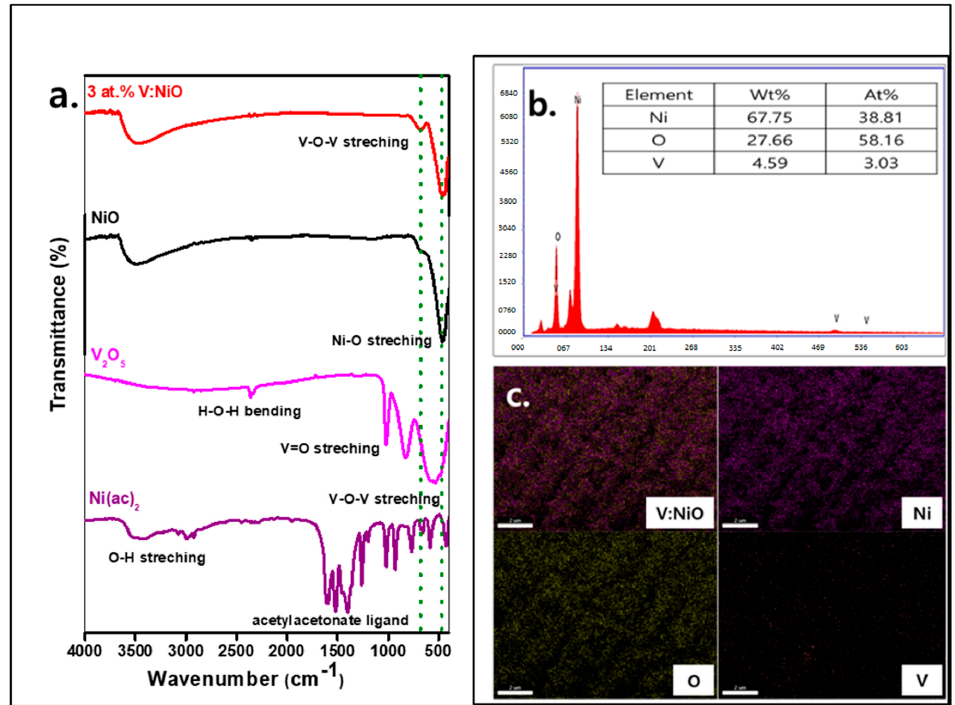
Figure 2. ( a ) FTIR spectra of NiO and 3 at.%V:NiO with precursor materials, ( b ) EDS spectra of